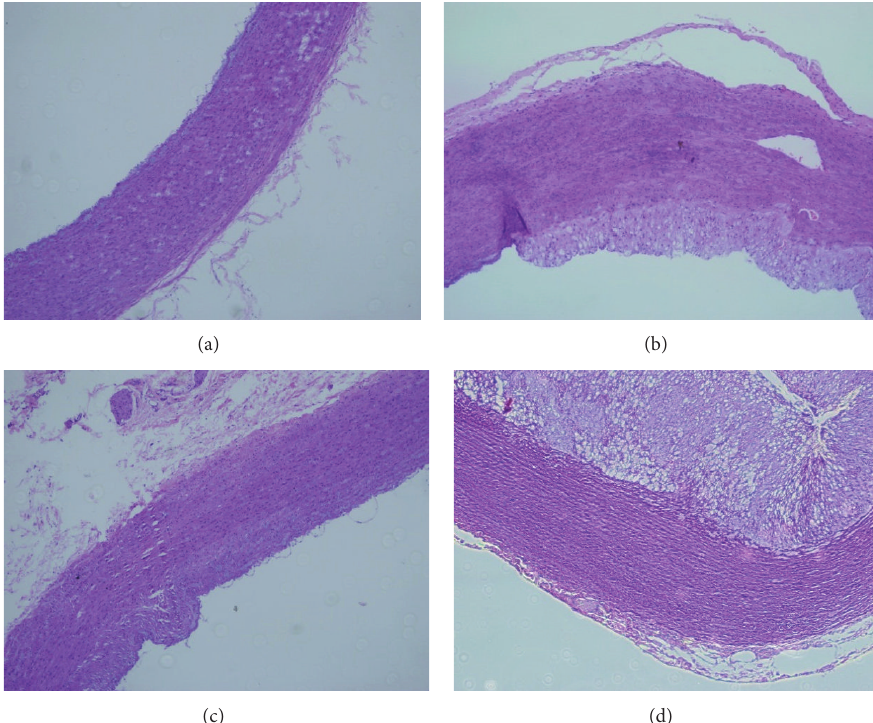
Figure 2: Aortic pathological changes ( × 100). (a) Group A; (b) Group B; (c) Group C; (d) Group D.